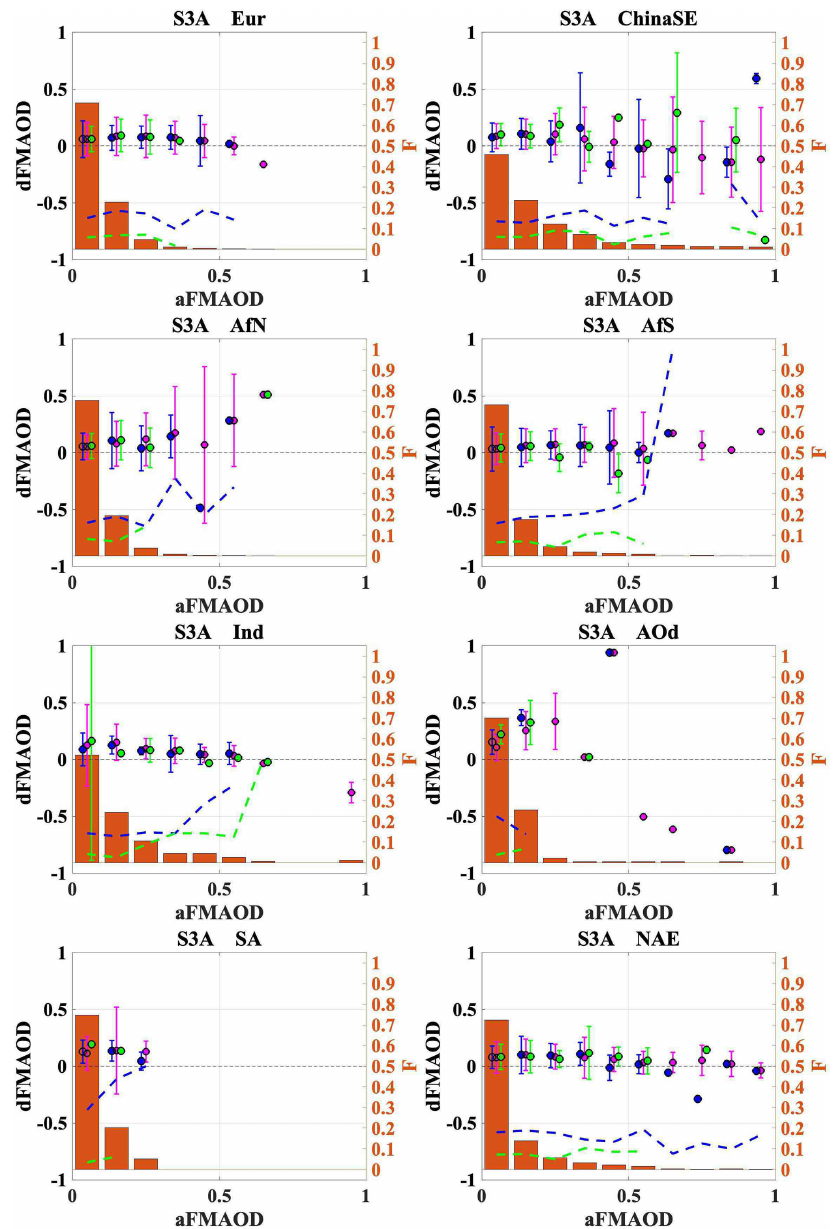
Figure 19. Regional (for Eur, ChinaSE, AfN, AfS, Ind, AOd, SA, NAE) difference (dFMAOD) between syFMAOD and aFMAOD for selected aFMAOD bins: median bias (circles) and bias standard deviation (error bars) for all AOD types (purple), aerosol fine-dominated AOD (blue) and coarse-dominated AOD (green). The fraction ( F ) of points in each bin from the total number of matchups is represented by orange bars. The fraction of fine-dominated matchups in each bin is shown as orange dashed-line. Results for other regions are in the Supplement (Fig.